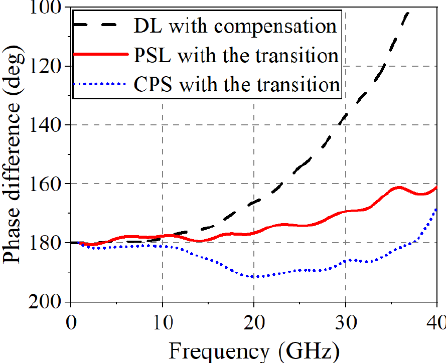
Figure 7. Phase differences between the two lines of the DL and the PSL in the presence of a 30 mil DL line imbalance (DL: DL linewidth of 10 mil, gap width of 5 mil, and distance L of 500 mil with a 5 mil FR-4 substrate, CPS: CPS linewidth of 10 mil, and gap width of 5 mil with a 5 mil FR-4 substrate, PSL: PSL linewidth of 5 mil with a 5 mil FR-4